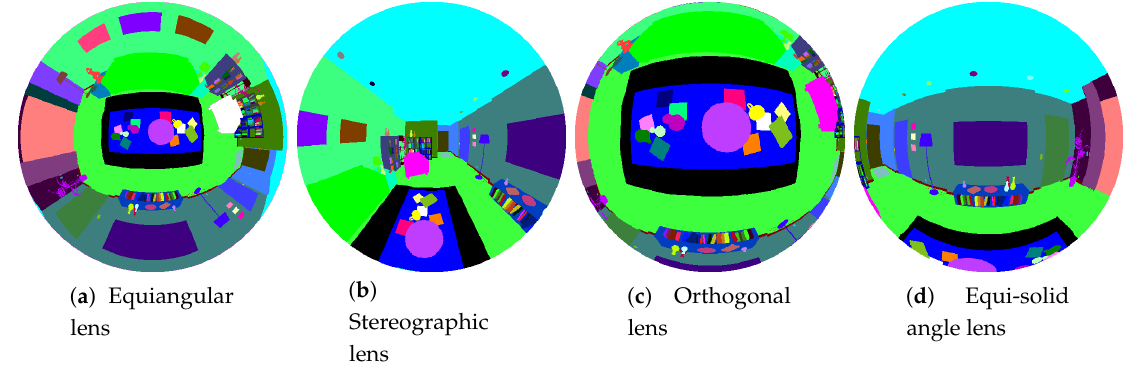
Figure A5. Semantic mode.